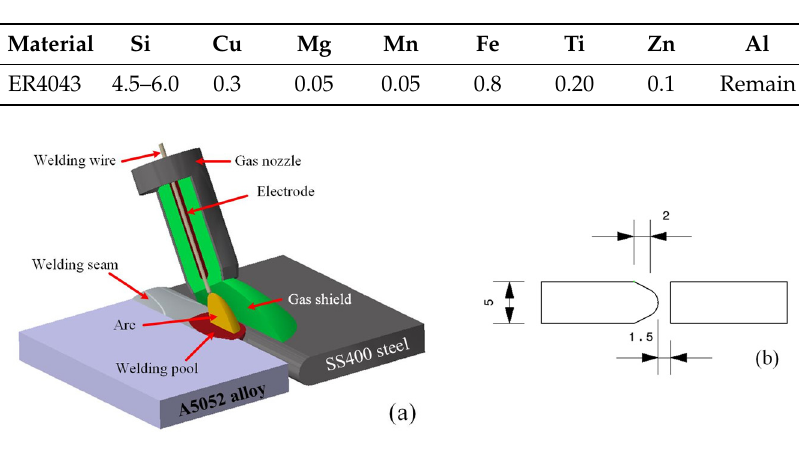
Table 2. Chemical composition of A5052 aluminum alloys (wt %).